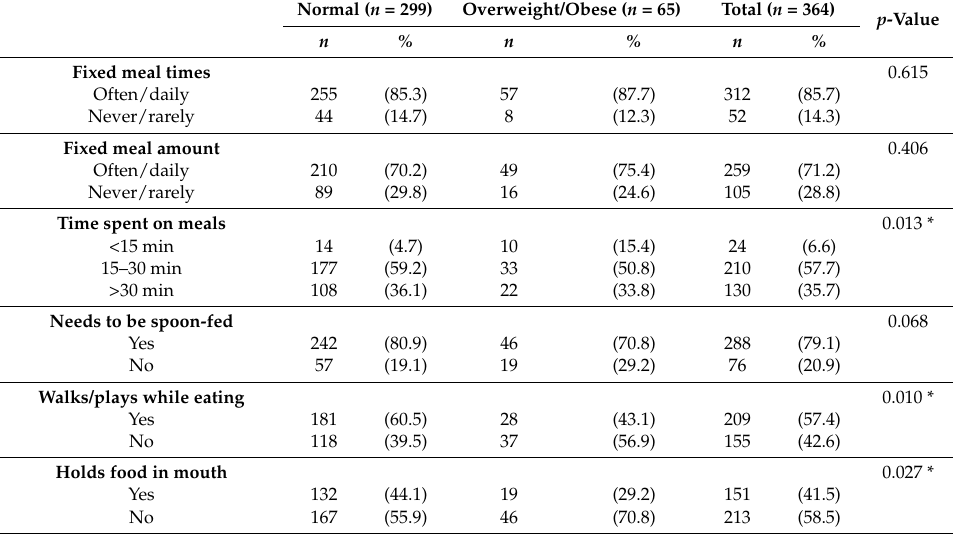
Table 2. Differences in dietary behaviors between normal-weight and overweight/obese